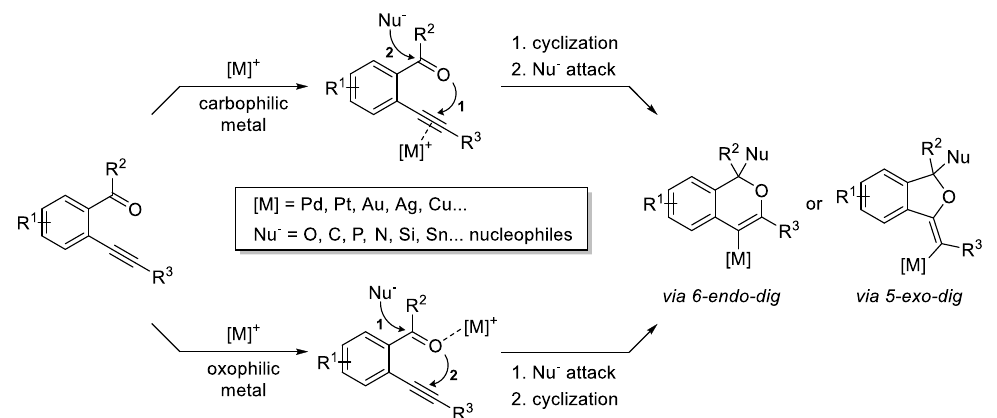
Scheme 2. General process for carbonyl-yne cyclization